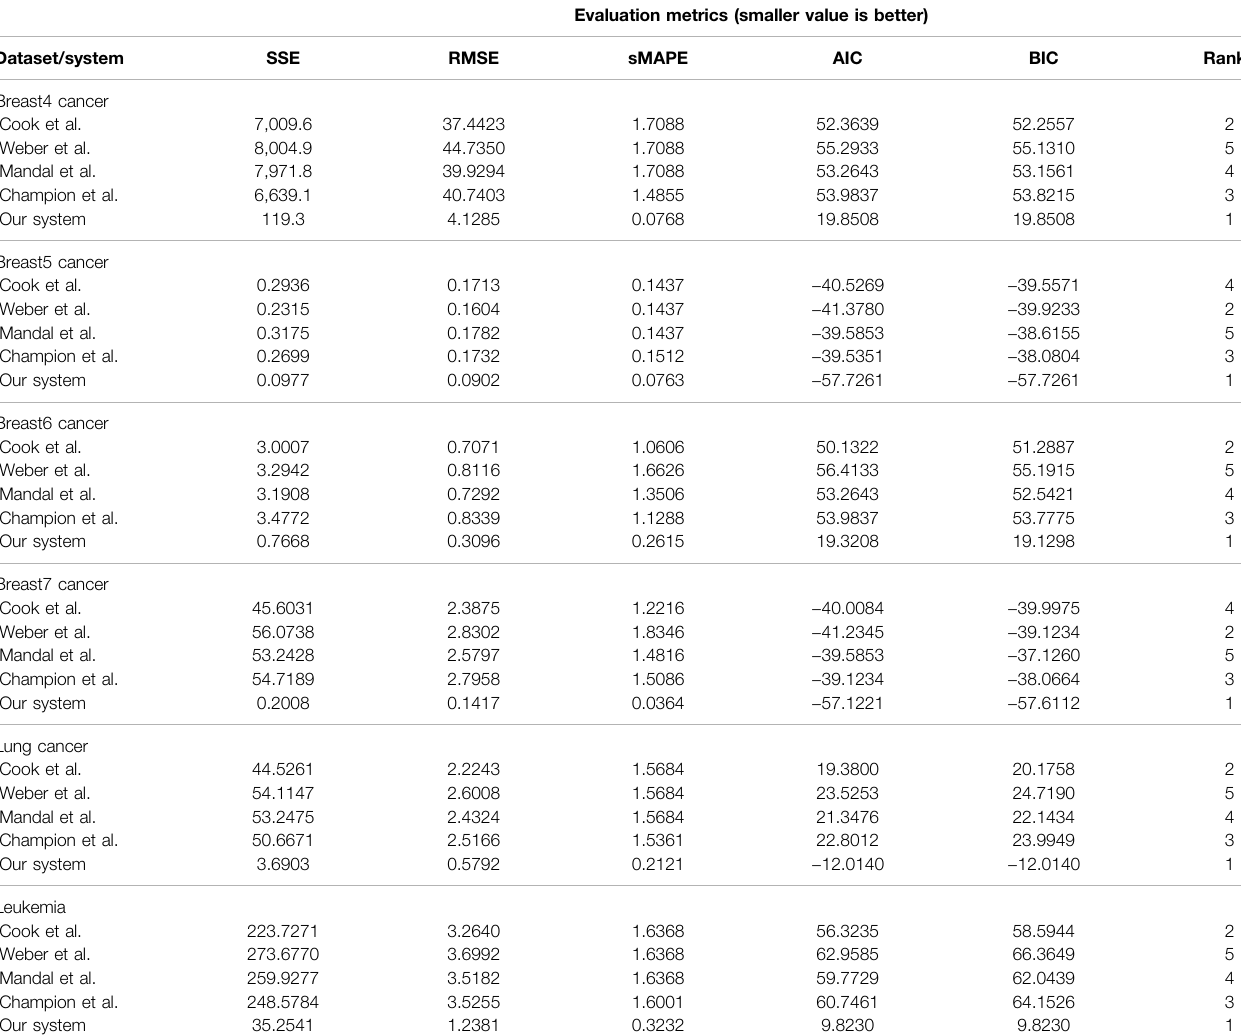
Evaluation metrics (smaller value is